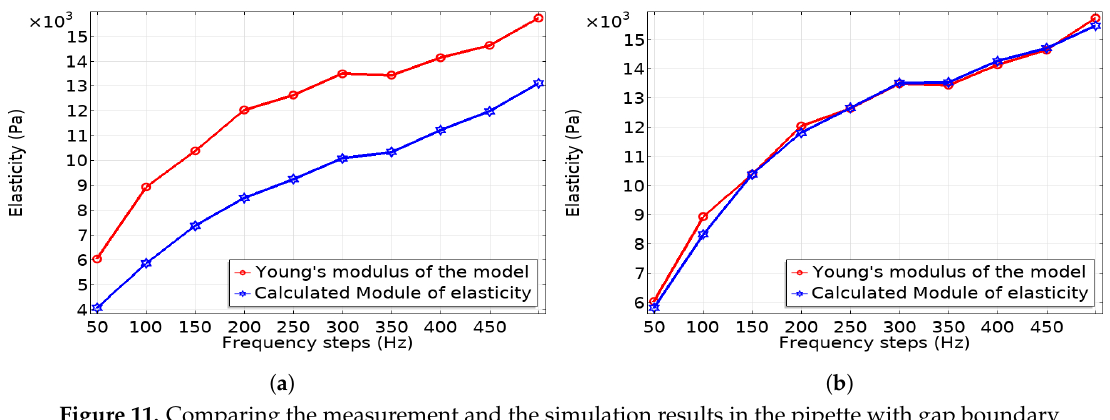
Figure 11. Comparing the measurement and the simulation results in the pipette with gap boundary condition; the Young’s modulus and the calculated elastic modulus, ( a ) by Equation (1) and ( b ) by Equation